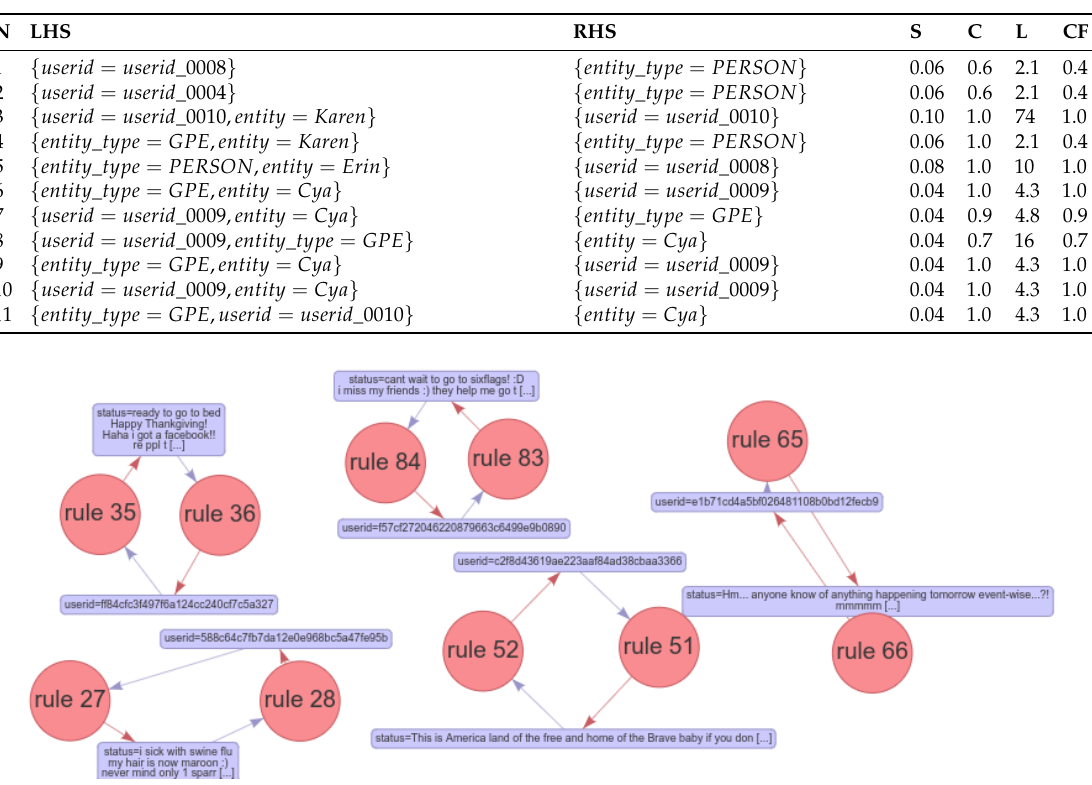
Figure 7. Some association rules before using proposed